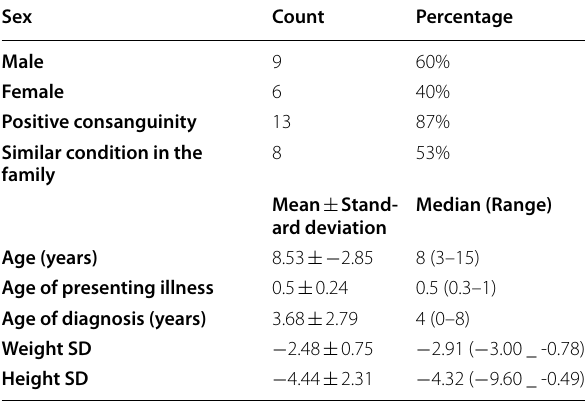
Table 1 Demographic data of the study population